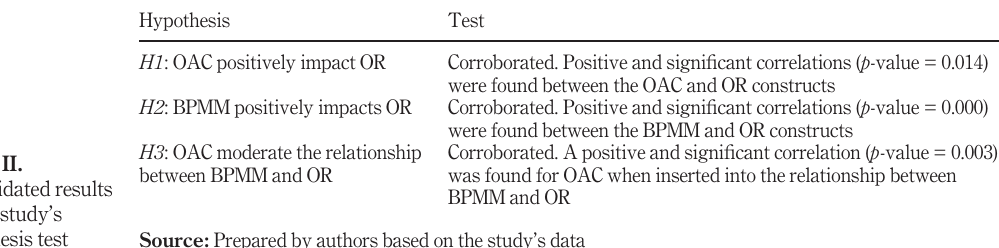
Table II. Consolidated results for the study ’